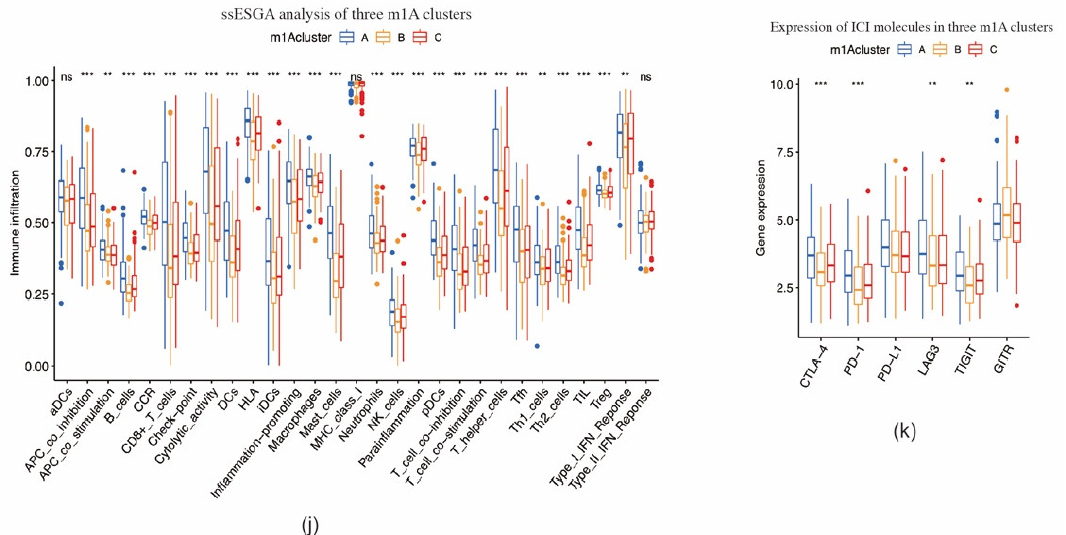
Figure 3. TIME–related characteristics of each m1A modification pattern. ( a ) Heat map of consensus clustering of 10 m1A regulators in oral squamous cell carcinoma. ( b ) Principal component analysis shows three m1A modification patterns could be clearly distinguished. ( c ) The expression of 10 m1A methylation regulators among m1A modification patterns. ( d ) The overall survival for 405 patients with oral squamous cell carcinoma within different m1A modification clusters ( p = 0.041, log–rank test). ( e ) m1A modification clusters in the validation cohort were also significantly related to overall survival ( p = 0.030, log–rank test). ( f – i ) Violin plots showing the immune, stroma, and ESTIMATE scores and tumor purity in three m1A modification clusters. ( j ) The abundance of each TIME–infiltrating cell in three m1A modification patterns. ( k ) The expression of immune checkpoint molecules in three m1A modification patterns. * p < 0.05; ** p < 0.01; *** p < 0.001; ns = not